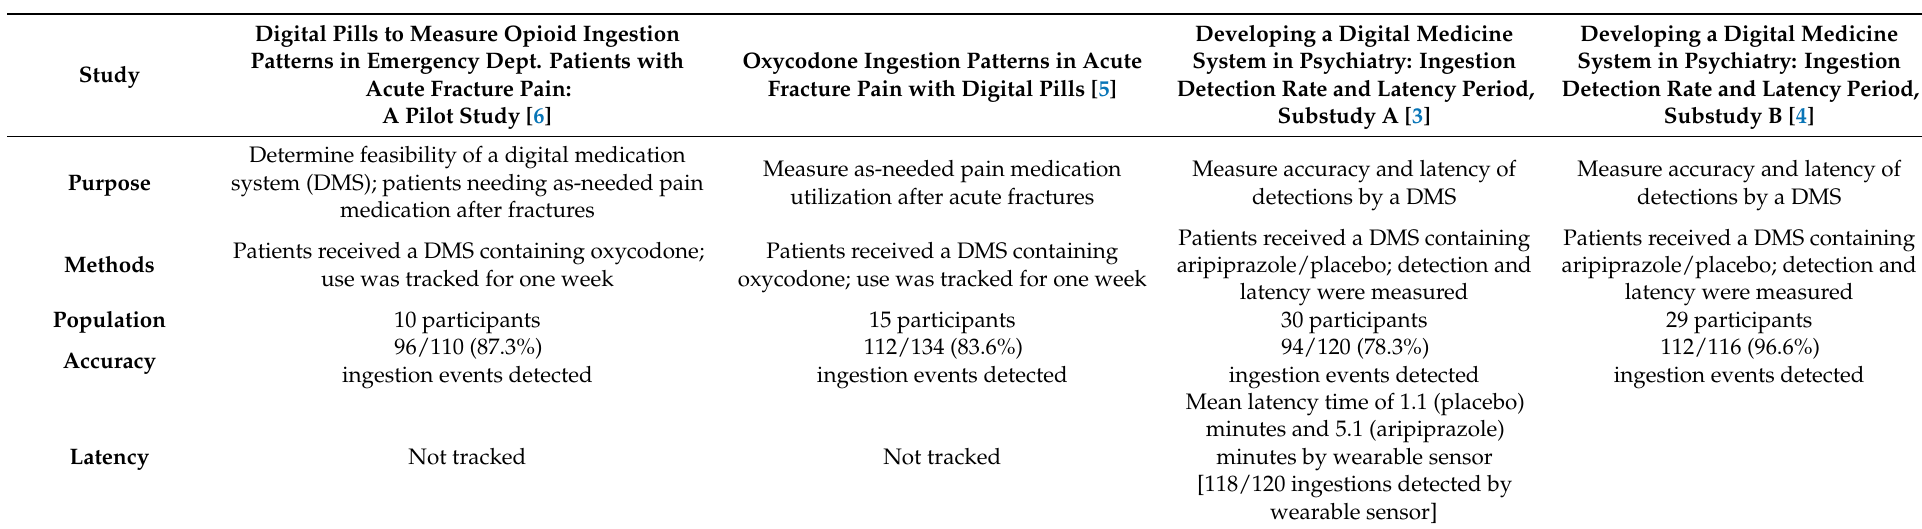
Table 1. Biosensing Study